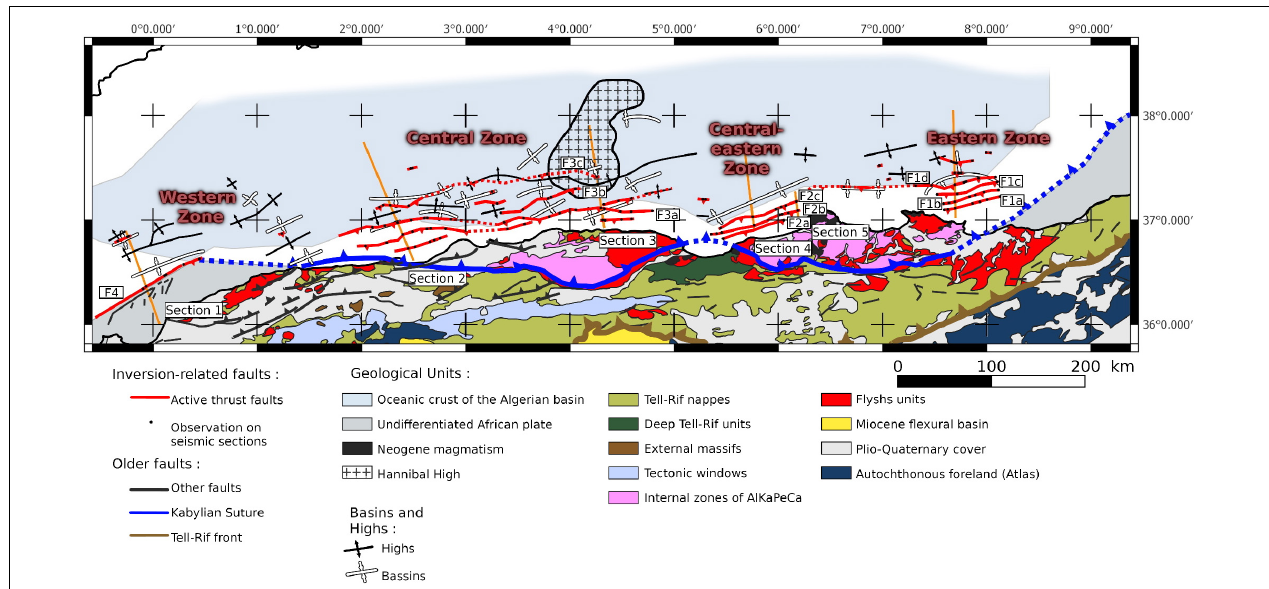
FIGURE 11 | Synthetic structural sketch of the Algerian margin displaying adjustments to already published fault systems based on the present work. Fault F4 is only partly shown on this